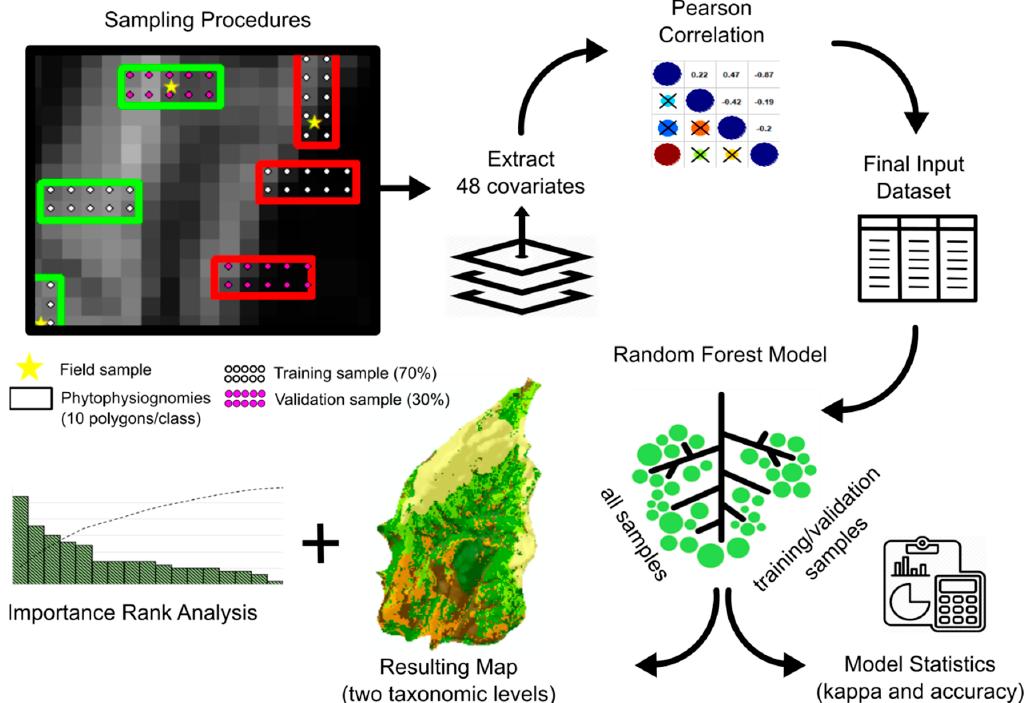
Figure 3. Flowchart of classification steps and procedures.